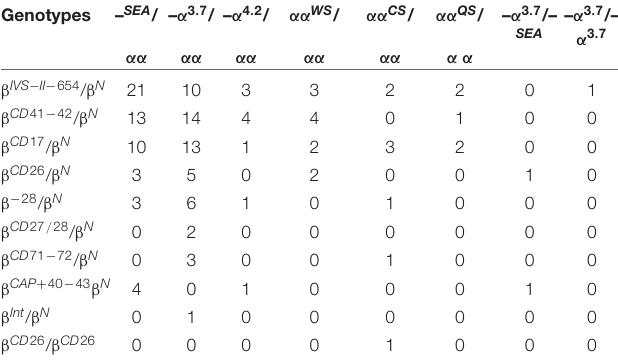
TABLE 4 | Distribution of compound α and β -thalassemia in Quanzhou